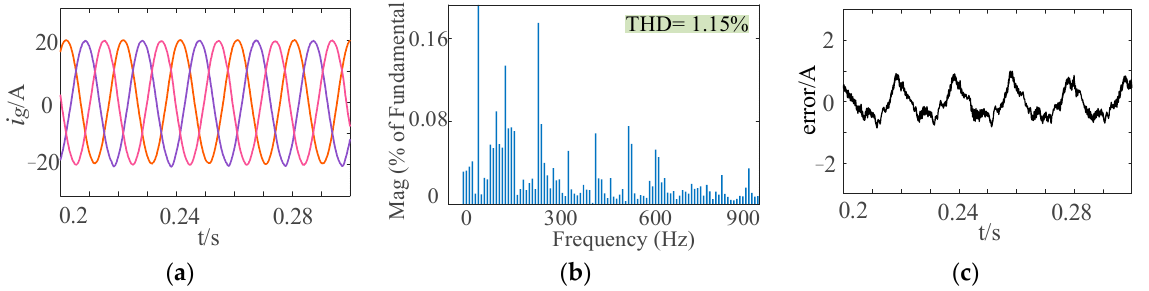
Figure 16. Simulation results of Farrow-FOPRRC at 50.8 Hz: ( a ) Grid current i g . ( b ) Harmonic spectrum of i g_c . ( c ) Current tracking error ɛ .